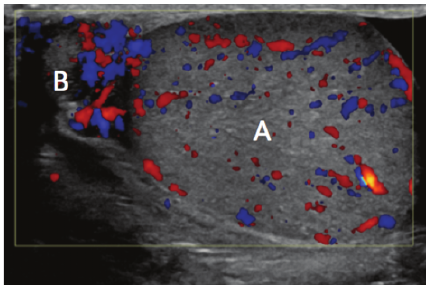
Figure 1: Right scrotal ultrasound with color Doppler interrogation at presentation to the ED showing A: right testis with preserved vascularity; B: right epididymis with enlargement and slightly increased vascularity.